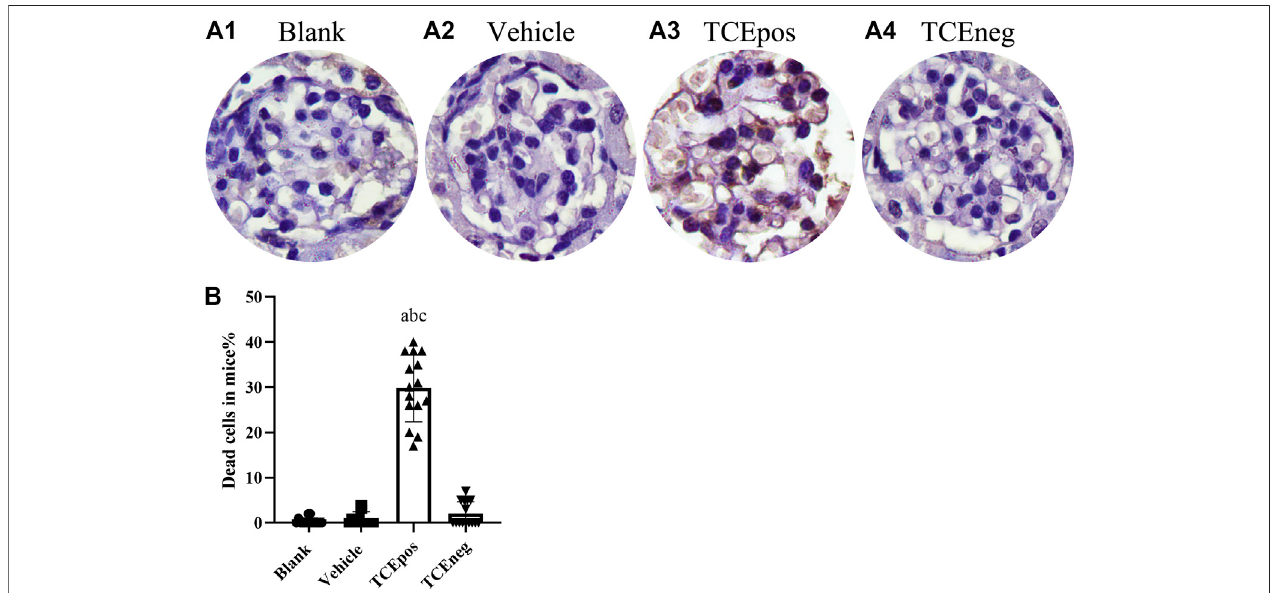
FIGURE 4 | An increase proportion of dead cells in TCE-induced kidney glomerular damage (A) Representative photographs of TUNEL staining in blank control group (A1) , vehicle control group (A2) , TCEpos group (A3) , and TCEneg (A4) . (B) The proportion of TUNEL staining positive cells in TCE-treated mice. Note: the brown of nuclei indicates the positive staining. Data are presented as mean ± SD and determined by one-way ANOVA, a P < 0.05, vs. blank control group; b P < 0.05, vs. vehicle control group; c P < 0.05, vs. TCEneg group.